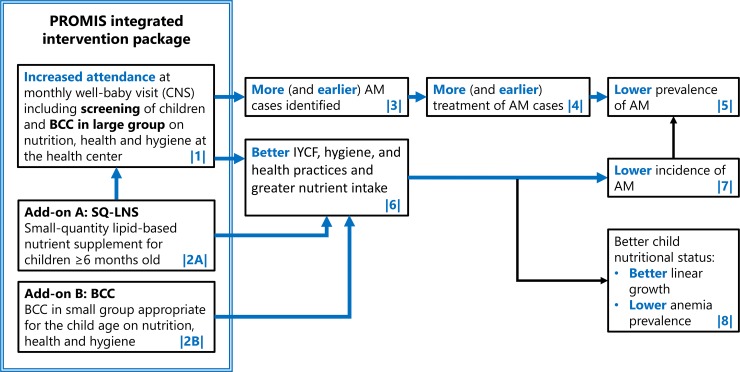
Theory of change of the integration of a preventive package at the well-baby visit.Hypothesized impacts of the intervention presented in this paper are shown in blue. AM, acute malnutrition; BCC, behavior change communication; IYCF, infant and young child feeding; PROMIS, Innovative Approaches for the Prevention of Childhood Undernutrition; SN-LNS, small-quantity lipid-based nutrition supplement.